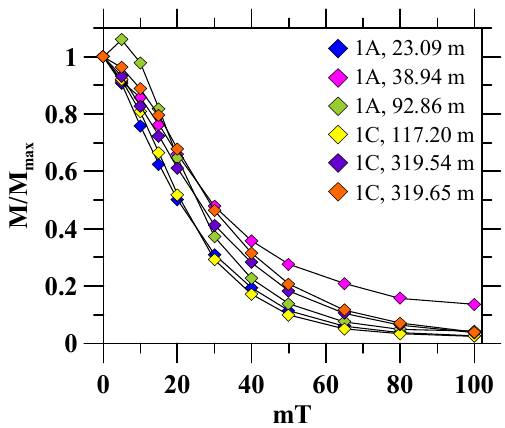
Fig. 4. Curves of normalized NRM intensity versus peak alternating field demagnetization steps from 0 to 100mT. Samples are the same as in Fig. 3. Smoothly reducing remanence is indicative of low- coercivity magnetic components dominating the remanence in these